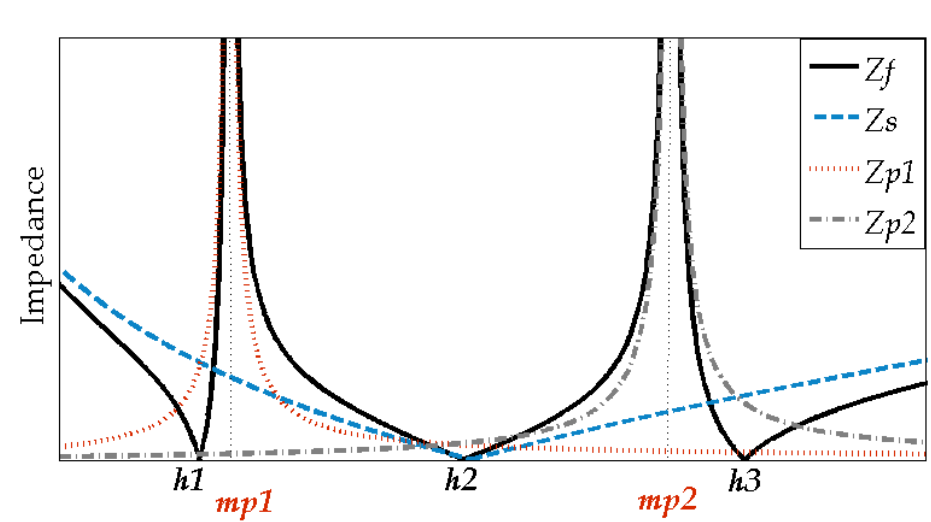
Figure 4. DTTF’s impedance characteristic .